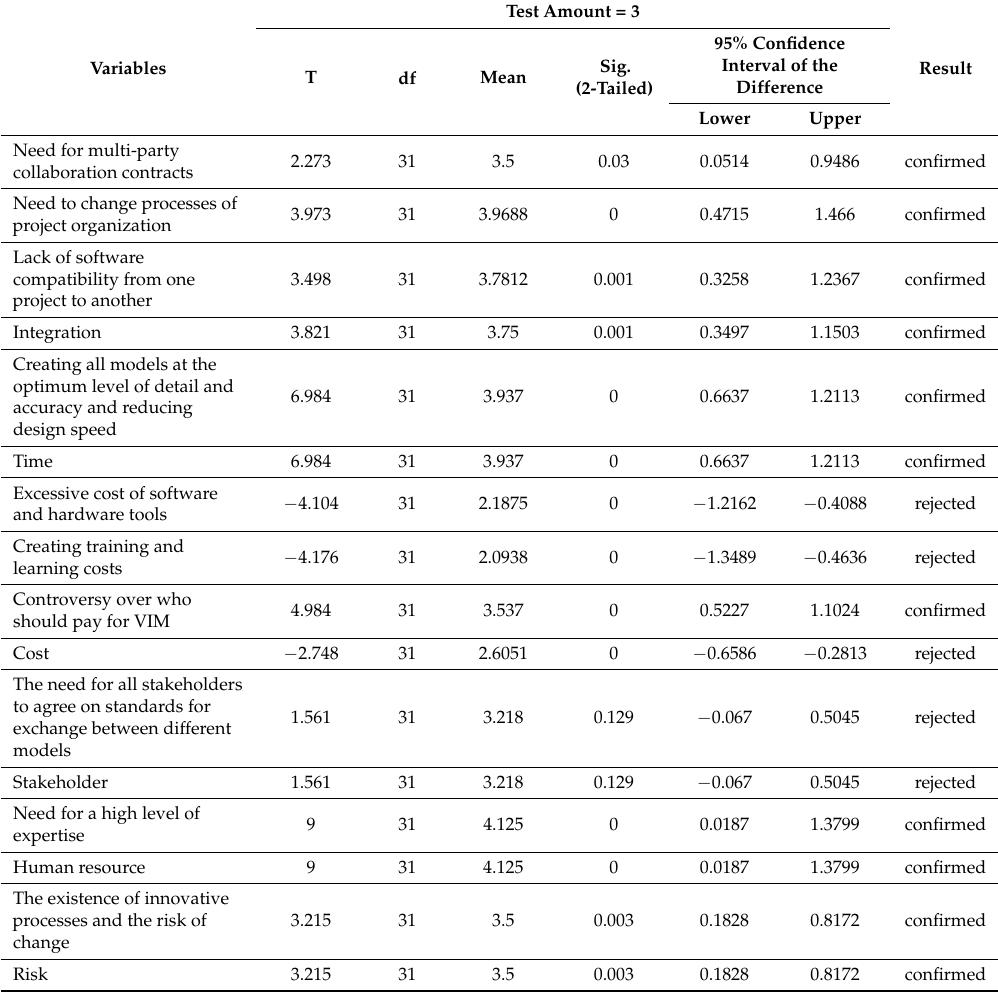
Table 9. One-Sample T Test Results for Evaluation of Challenges of VIM